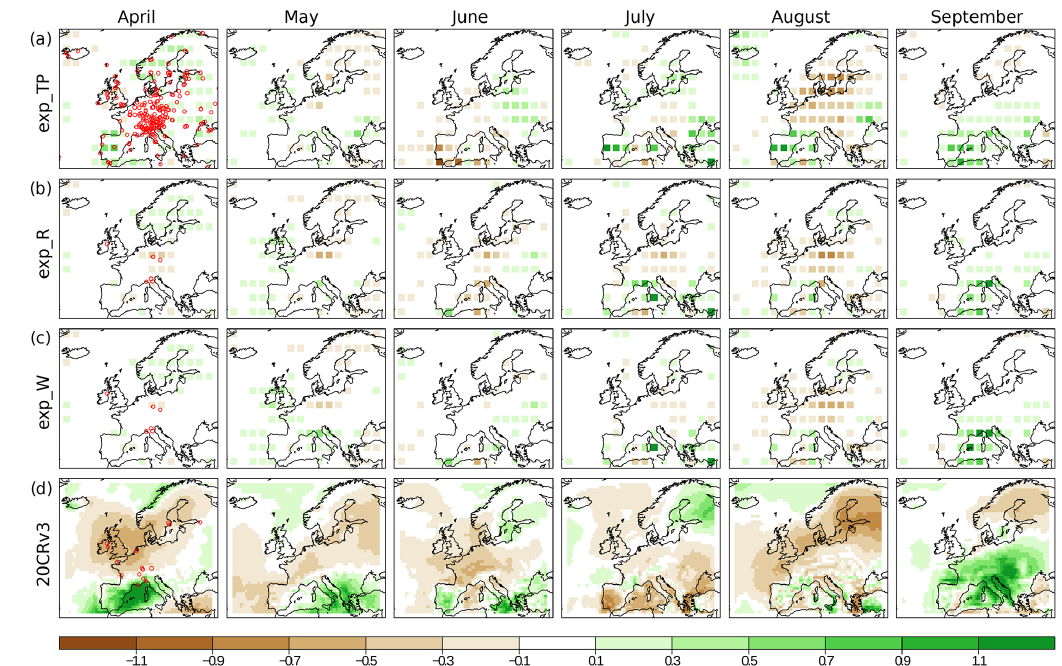
Figure 7. Relative precipitation anomalies over Europe in 1842. Monthly relative precipitation anomaly fields between April and September from exp_TP (a) , exp_R (b) , exp_W (c) , and 20CRv3 (d) are depicted. Note that the anomalies are calculated from the 1807–1877 period for exp_TP, exp_R, and exp_W, as well as for 1836–1877 for 20CRv3. The red circles indicate the location of the time series used as input in the assimilations.